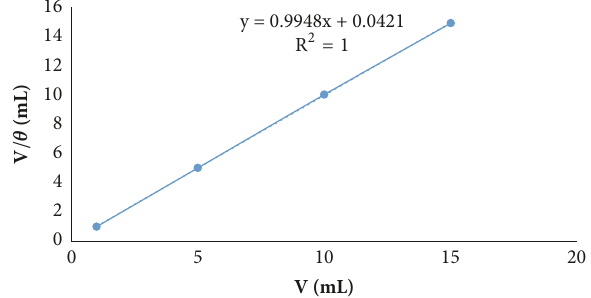
Figure 7: Langmuir isotherm of Monodora myristica on the syner- gism of steel and zinc in 0.1M sulphuric